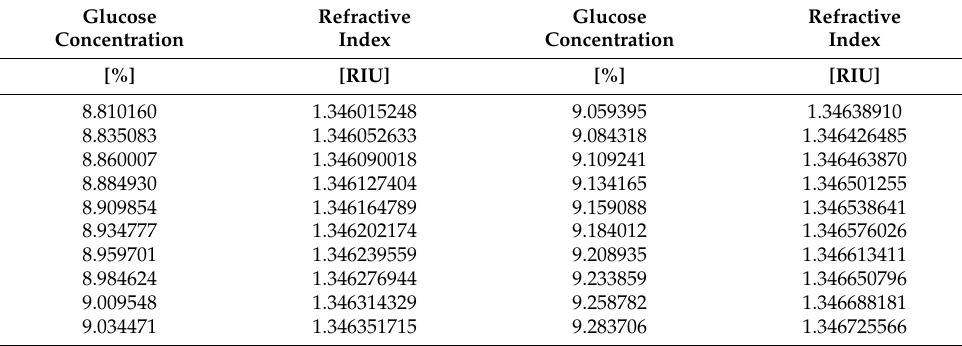
Table 2. The refractive index values of the analyte used.